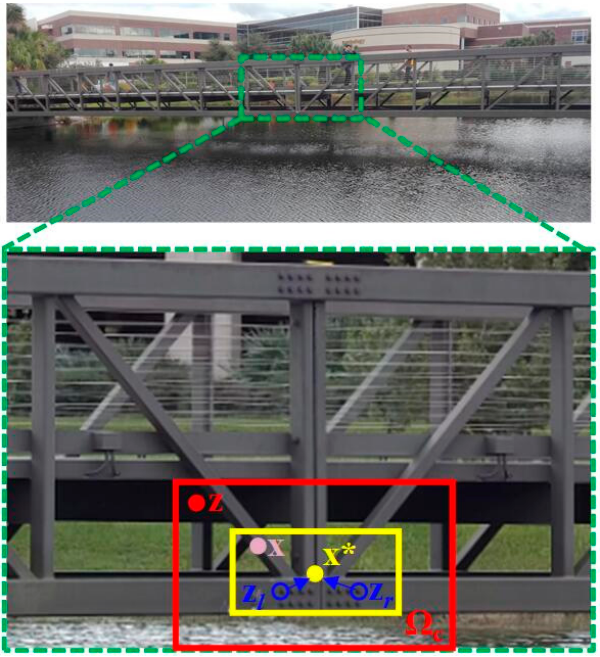
Figure 2. Graphical model of spatial relationship between the target and its surrounding context.